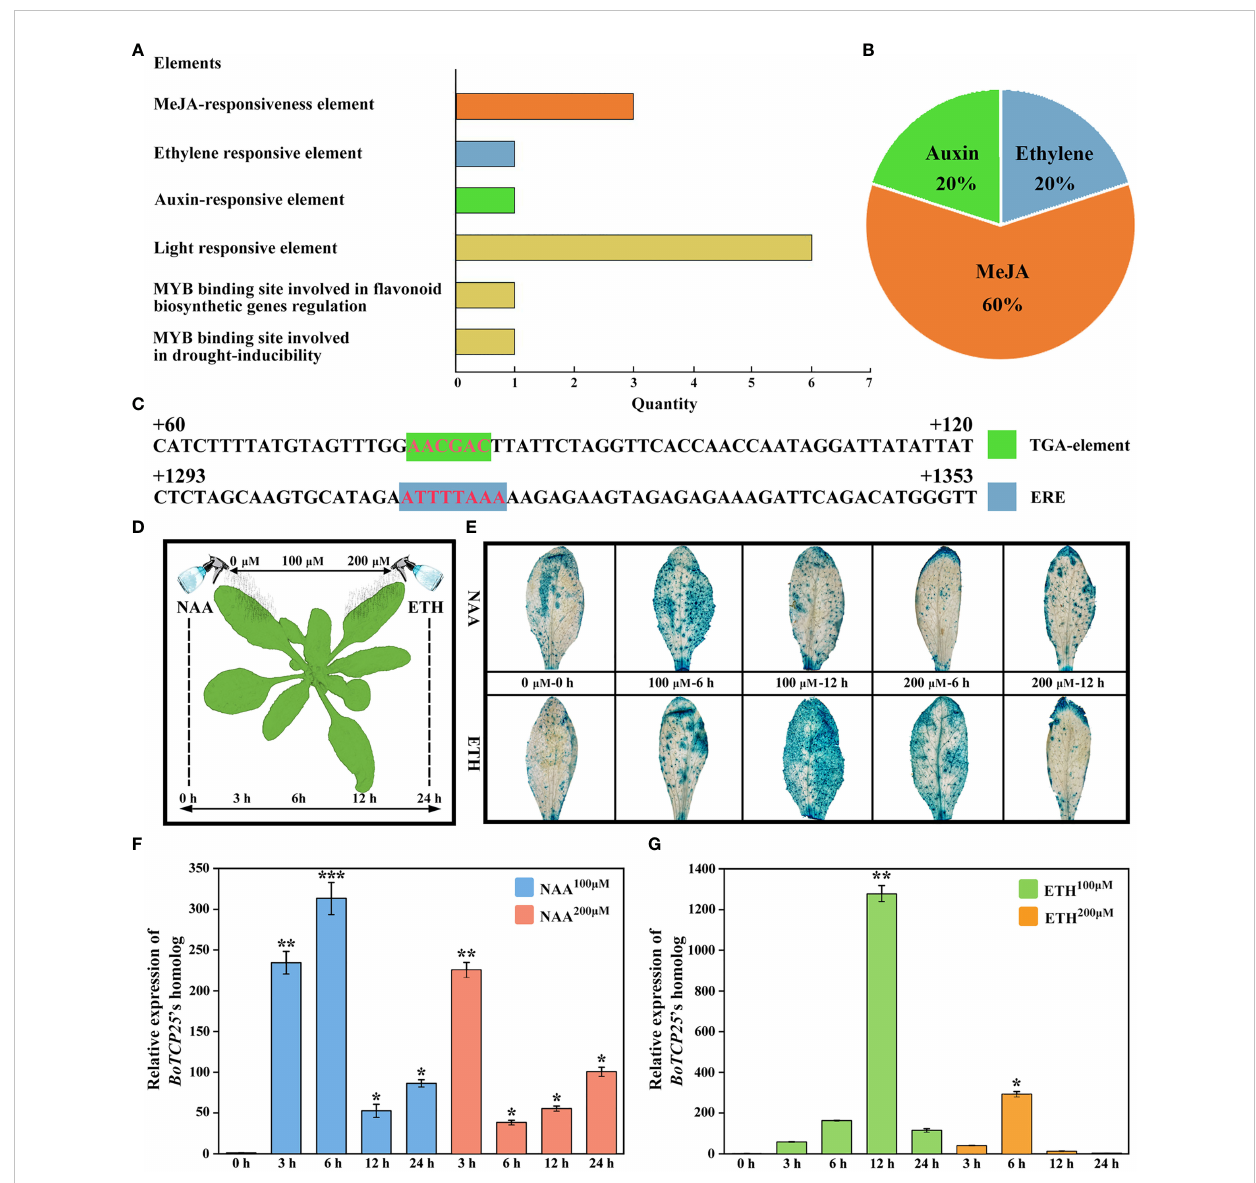
FIGURE 7 Analysis of cis-acting elements of BoTCP25 ’ s promoter and their response to exogenous hormone treatments. (A) Prediction of cis-acting elements of BoTCP25 ’ s promoter. (B) Percentage of cis-acting elements of BoTCP25 ’ s promoter in response to different plant hormones. (C) Analysis of potential binding sites of auxin and ethylene on the BoTCP25 promoter. (D) Diagram of exogenous hormone treatment on pCAMBIA1301- BoTCP25 pro -GUS Arabidopsis plants. (E) Response of BoTCP25pro -GUS to auxin and ethylene treatments. Relative expression of BoTCP25 ’ s homolog in Arabidopsis under different concentrations of auxin (F) and ethylene (G) at different time points. *p<0.05, **p<0.01, and